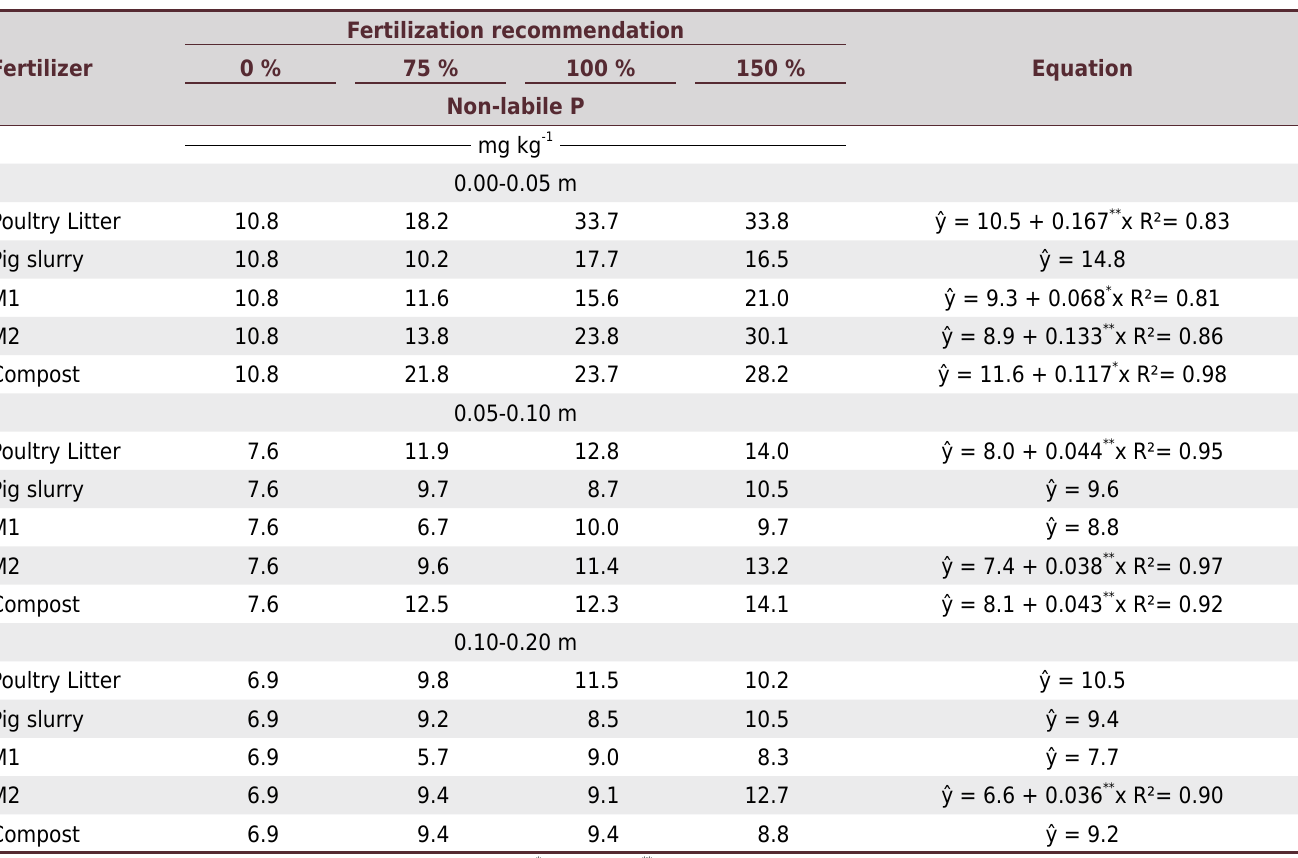
Table 7. Non-labile soil phosphorus fraction extracted through the HCl 1 mol L -1 in the 0.00-0.05, 0.05-0.10, and 0.10-0.20 m layers after six years use of organic and mineral fertilizers in a Rhodic Kandiudox Fertilization Fertilizer